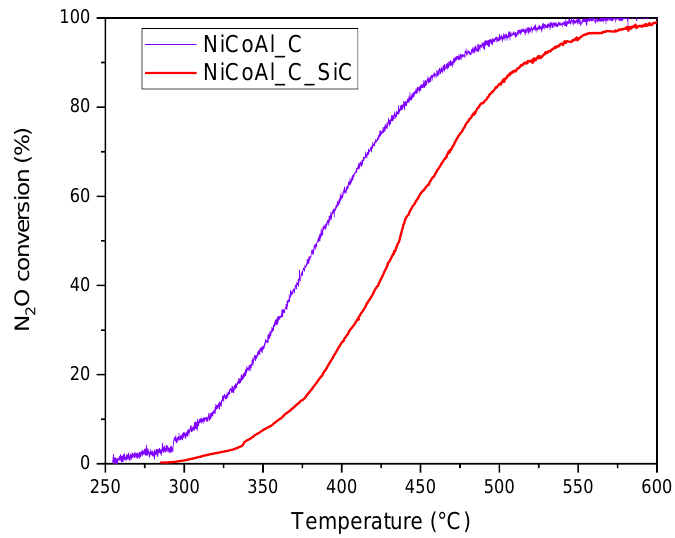
Figure 14. Activity comparison between powder catalyst and structured catalyst. Operating condi- tions: WHSV = 19 h − 1 , 1 atm, reagent mixture: 10 vol% N 2 O in Ar.